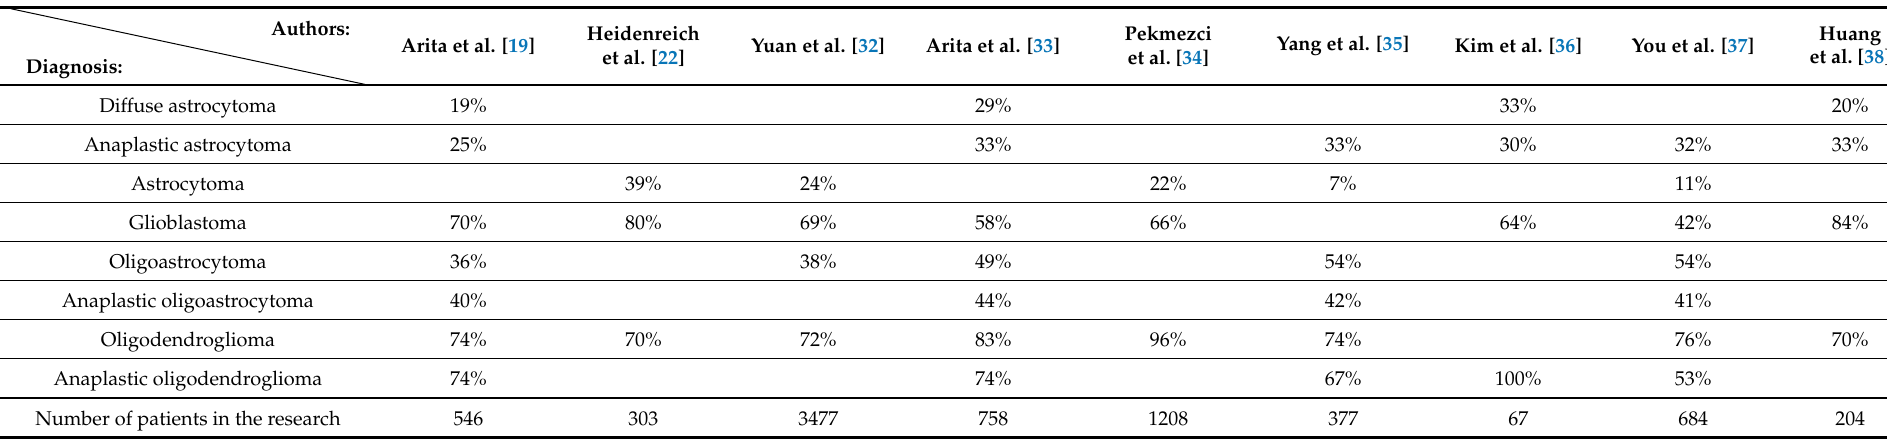
Table 1. Frequency of TERT mutations in different types of gliomas (type of mutation TERTp : C228T and C250T,